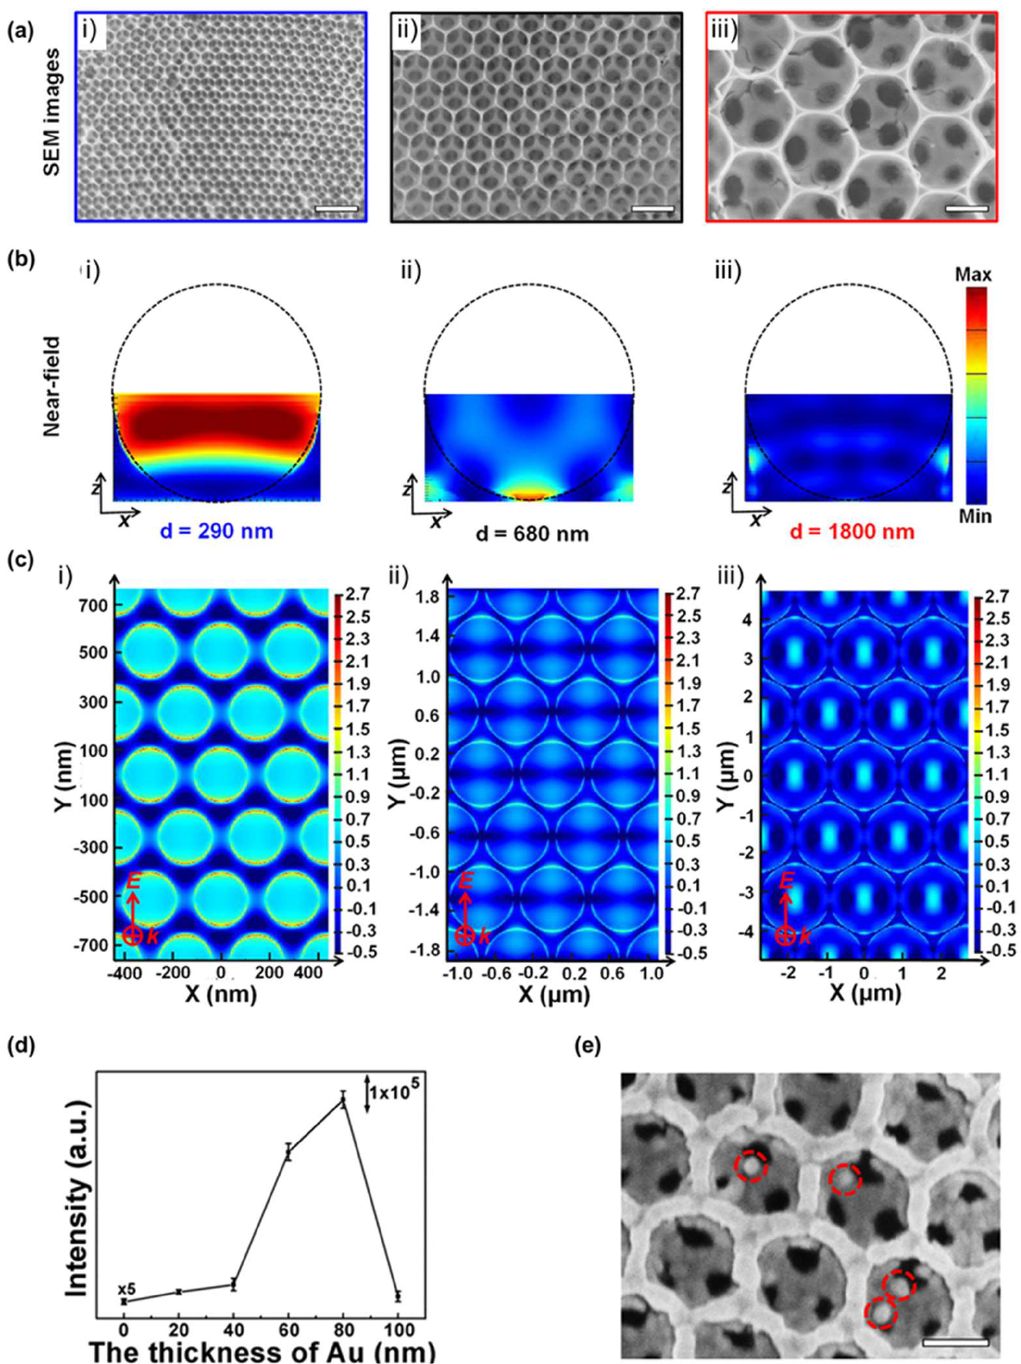
Figure 5. Au-coated TiO 2 beehive structure substrate for exosome detection. (see [50]) ( a ) SEM images of the TiO 2 MIO structure (i) 290 nm, (ii) 680 nm, and (iii) 1800 nm. The scale bars represent 1 μm. ( b ) Near-field simulation for the light trapping result at (i) 290 nm, (ii) 680 nm, and (iii)1800 nm sizes of TiO 2 MIO structures. ( c ) FDTD simulation results for EM field enhancement at the 80 nm-thick Au-coated TiO 2 beehive structures with pore sizes of (i) 290 nm, (ii) 680 nm, and (iii) 1800 nm. ( d ) SERS intensity of methylene blue at 1623 cm –1 with different thicknesses of the Au layer on the 290 nm beehive structures. ( e ) SEM image of EVs captured by the 80 nm Au-coated 290 nm TiO 2 beehive structures. Circled areas are the EVs. The scale bar represents 300 nm. Adapted with permission from Ref [50]. Copyright 2020 American Chemical Society.